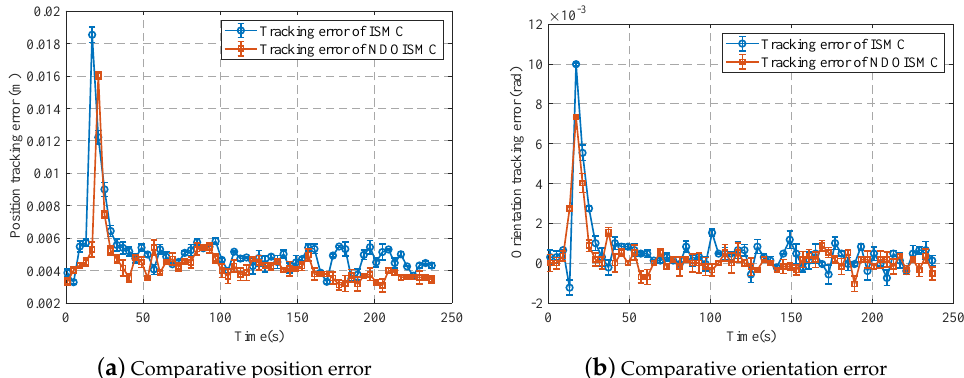
Figure 8. Experimental comparison result for Case B: wet floor